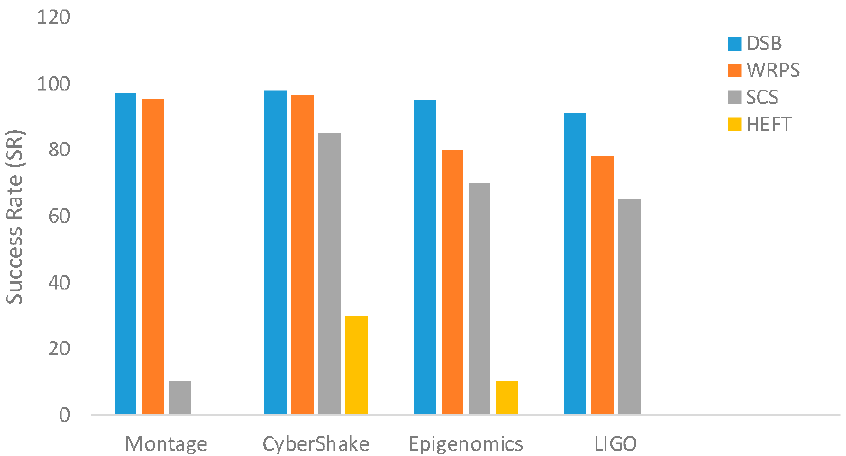
Figure 9. Valid Schedule Rate (VSR) versus Normalized Deadline (ND).